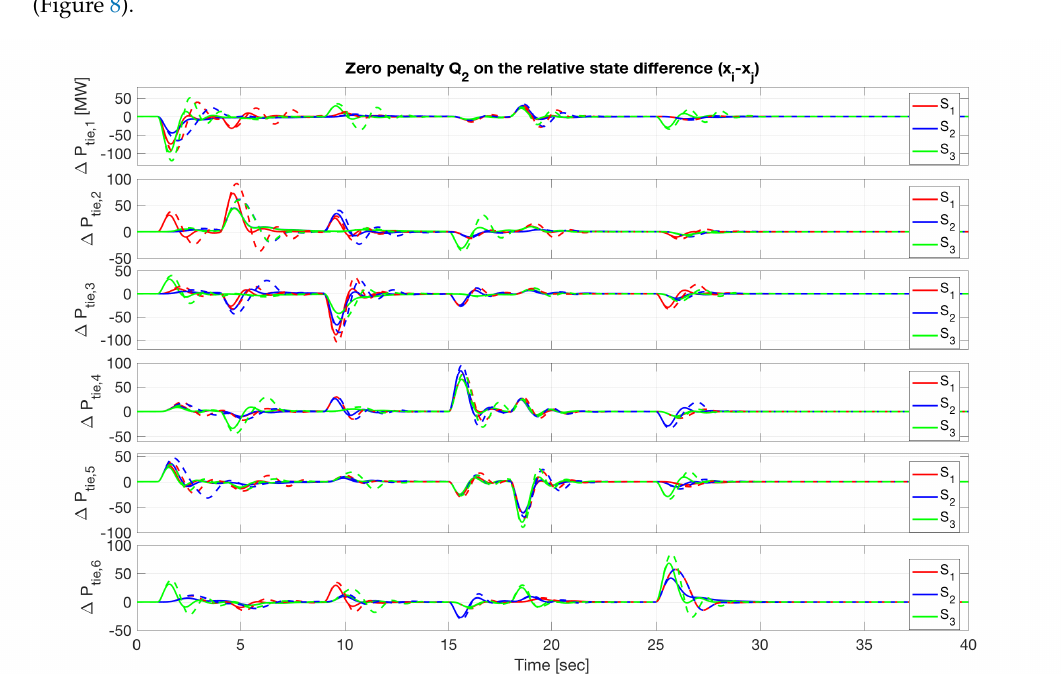
Figure 10. Total power inflow response of the six-area power system for three tie-line interconnection schemes ( S 1 , S 2 , S 3 ) . Zero penalty on the relative state-difference between interconnected areas. Solid lines depict transients of the linear model; dashed lines depict transients of the model with saturator (Figure